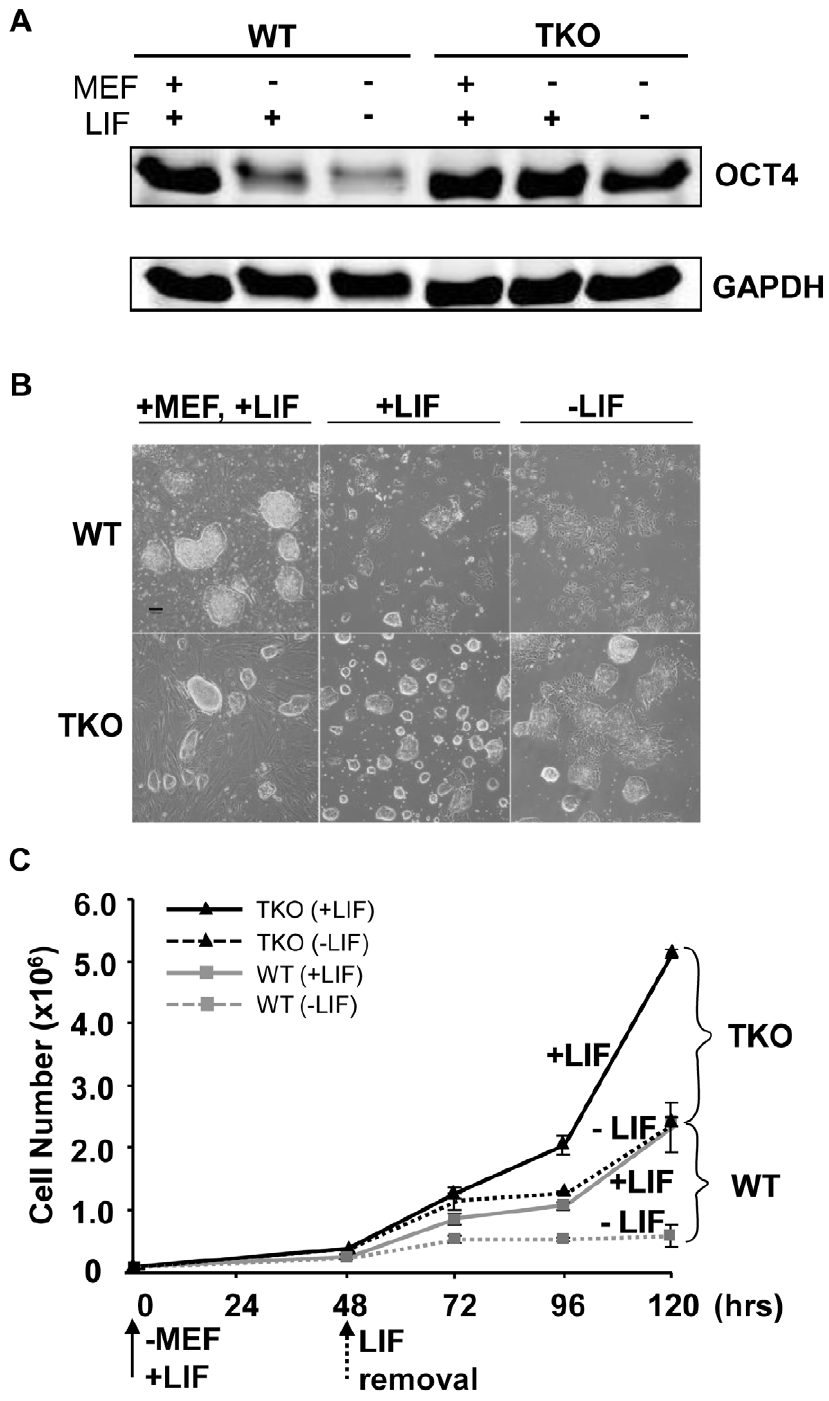
Figure 1. Loss of H1c/H1d/H1e inhibits spontaneous ESC differentiation. (A) Western blot analysis of OCT4 level in WT and H1 TKO ESCs cultured under indicated conditions for 2 days. (B) Phase images of WT and H1 TKO ESCs cultured either on MEF with LIF (left panel), gelatin coated plate with LIF (middle panel), or gelatin coated plate without LIF (right panel) for 2 days. Scale bar: 100 m m. (C) Growth curves of WT and H1 TKO ESCs cultured on gelatin coated plate with or without LIF. Data are presented as average 6 S.D. tency genes as well as important developmental genes for clustered most similarly in hierarchical cluster analysis (Figure 2C, transcription factors and signaling molecules for all three germ 2Di, and Figure S2Bi). WT EBs differentiated as expected with significant increases of many differentiation markers and de- layers. WT and TKO cultures at day 0 displayed very few differences in gene expression and their gene expression profiles creased expression of pluripotency associated genes (Figure 2C,